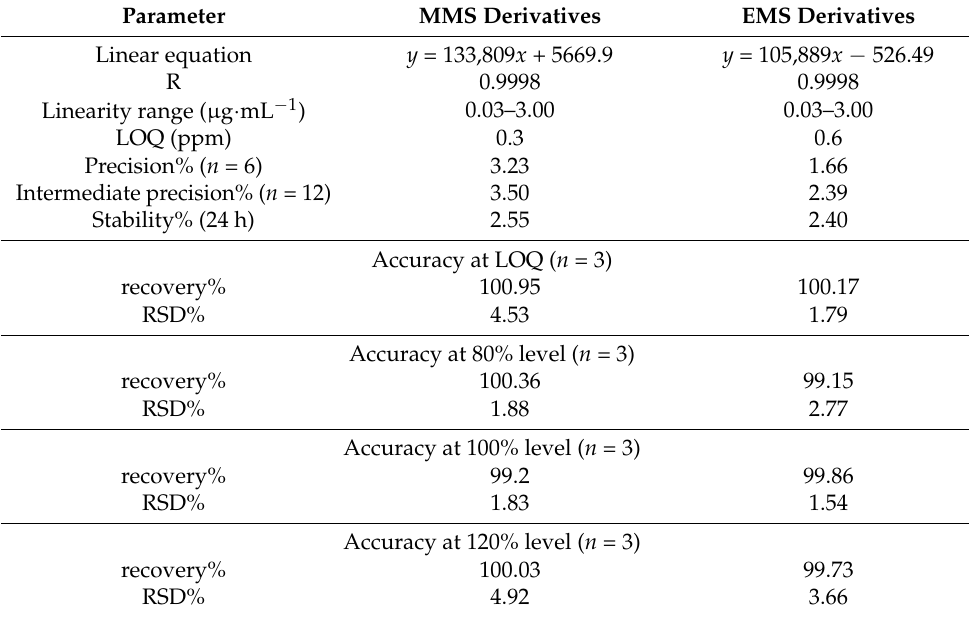
Table 2. Summary report of the method validation.